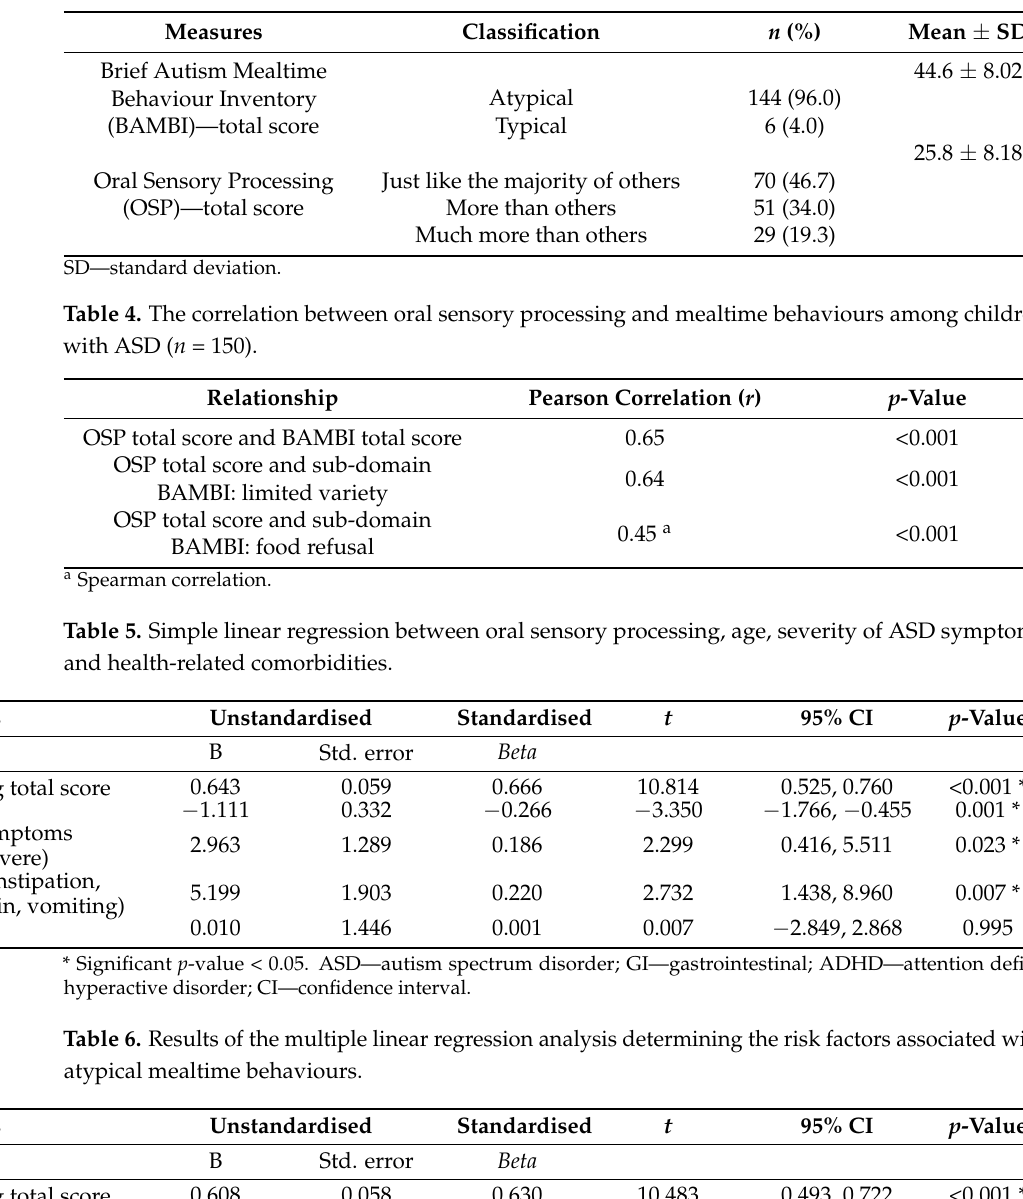
Table 3. Frequency of atypical mealtime behaviours and oral sensory processing difficulties among children with ASD ( n = 150).